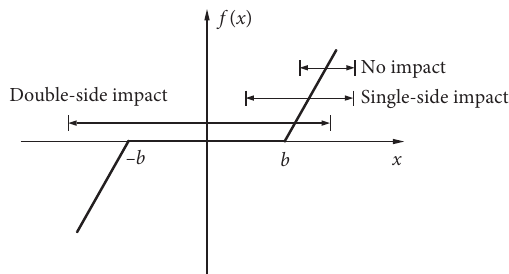
Figure 2: Meshing impact state of double-helical gear